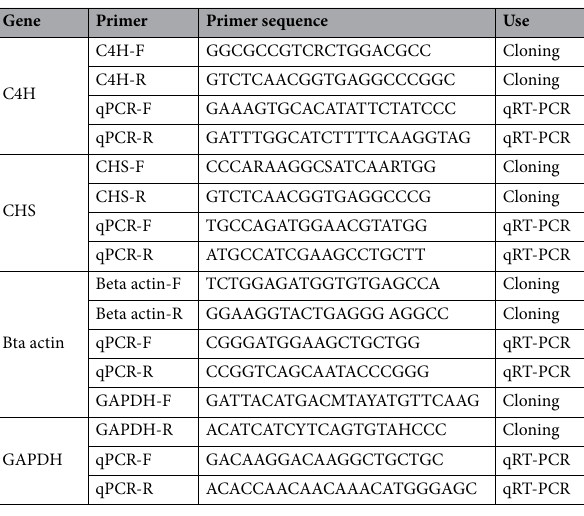
Table 5. Primers used in the